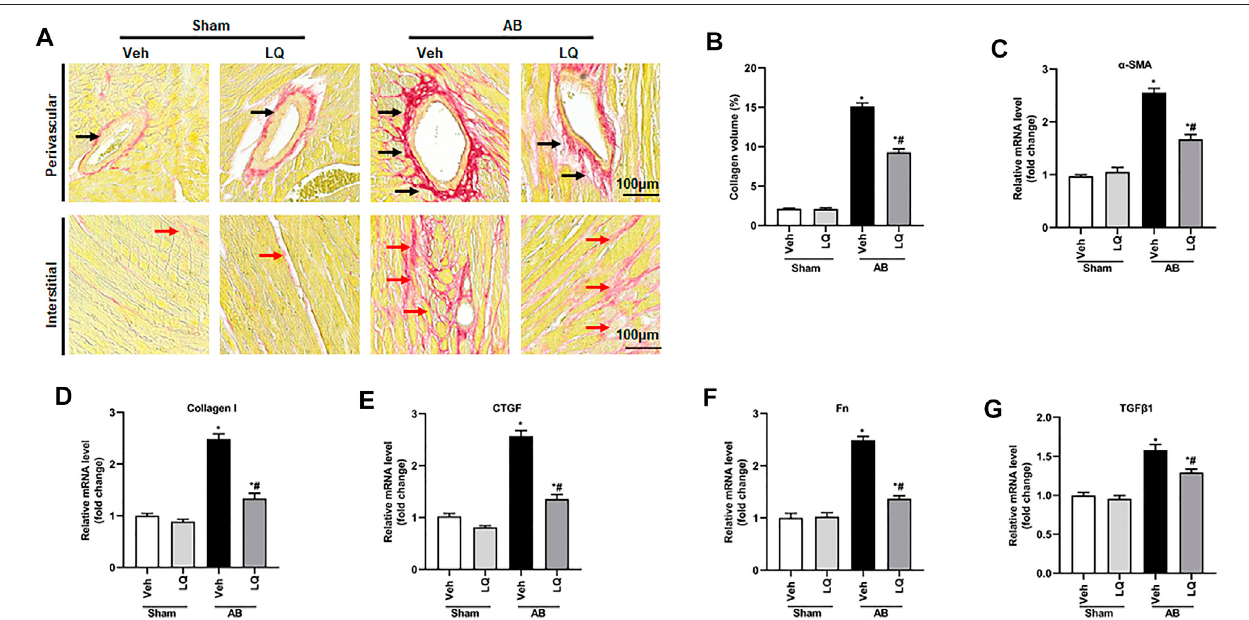
FIGURE3| Liquiritinattenuatescardiac fi brosis invivo . (A) Representativeimagesofpicrosiriusred(PSR)stainingtoassessinterstitial(redarrows)andperivascular (blackarrow) fi brosis. (B) Estimationofcardiac fi brosisareaaccordingtoPSRstaining( n =6).RelativemRNAlevelsof (C) α -SMA, (D) collagenI, (E) CTGF, (F) Fn,and (G) TGF β 1 ( n = 6). mRNA expression of target genes was normalized to GAPDH. Data are presented as the mean ± SEM. One-way ANOVA was performed to examine statistical differences among different groups. * p < 0.05 vs. Sham + Veh; # p < 0.05 vs. AB + Veh.